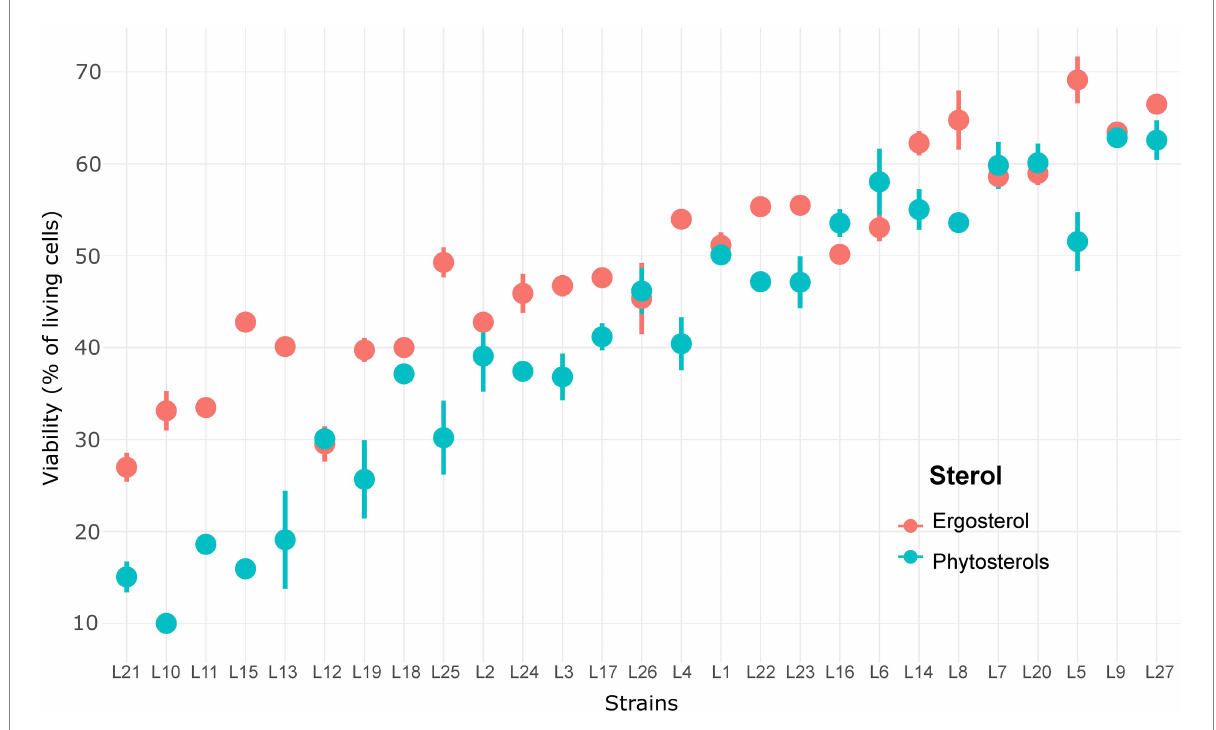
FIGURE 3 Viability of 27 S. cerevisiae strains under sterol limitation with ergosterol and